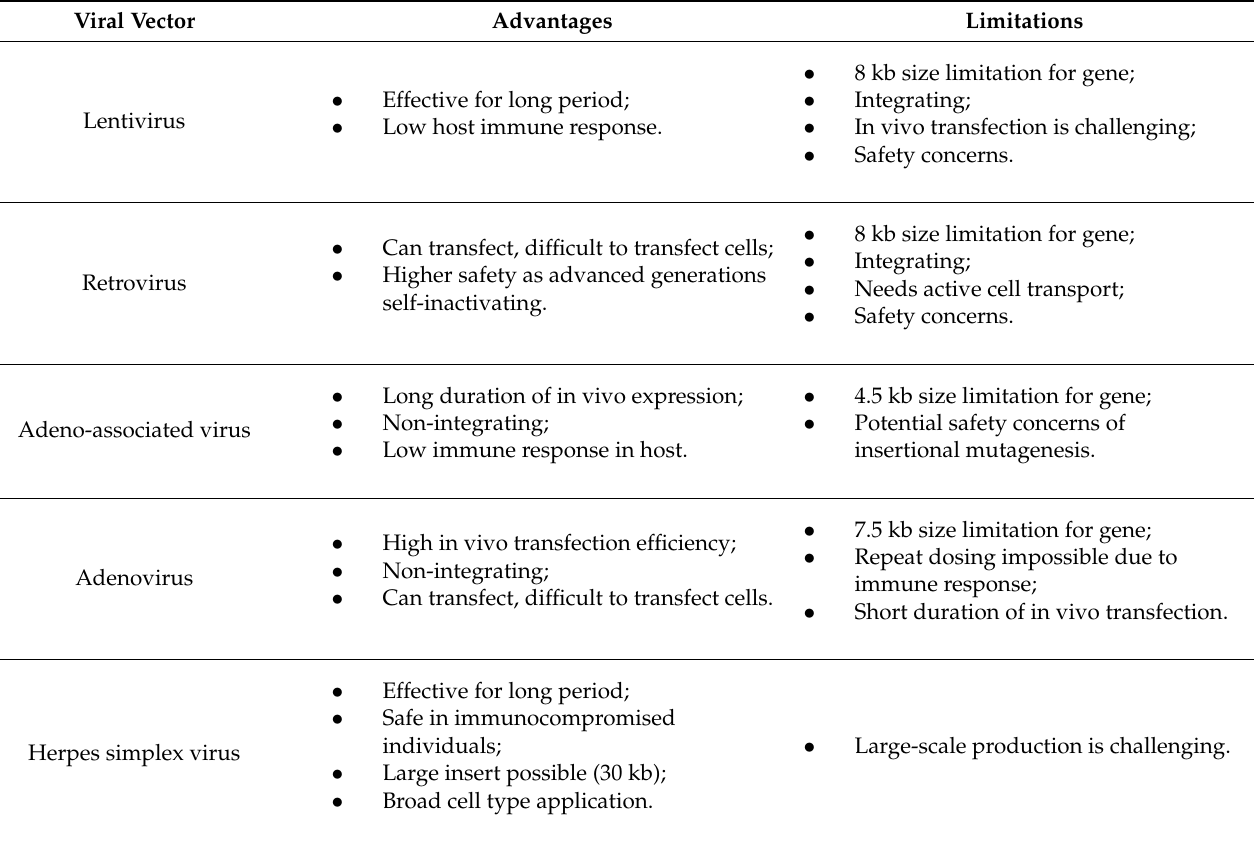
Table 2. Advantages and limitations of viral